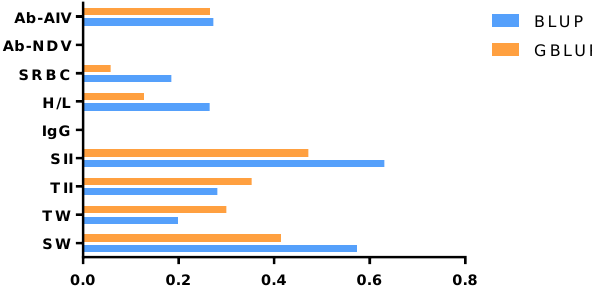
Figure 1. Comparison of heritability estimated with the best linear unbiased prediction (BLUP) model (Blue bar) and genetic linear unbiased prediction of genomes (GBLUP) model (orange bar). The x -axis is the value of heritability, and the y -axis is the name of the immune trait.